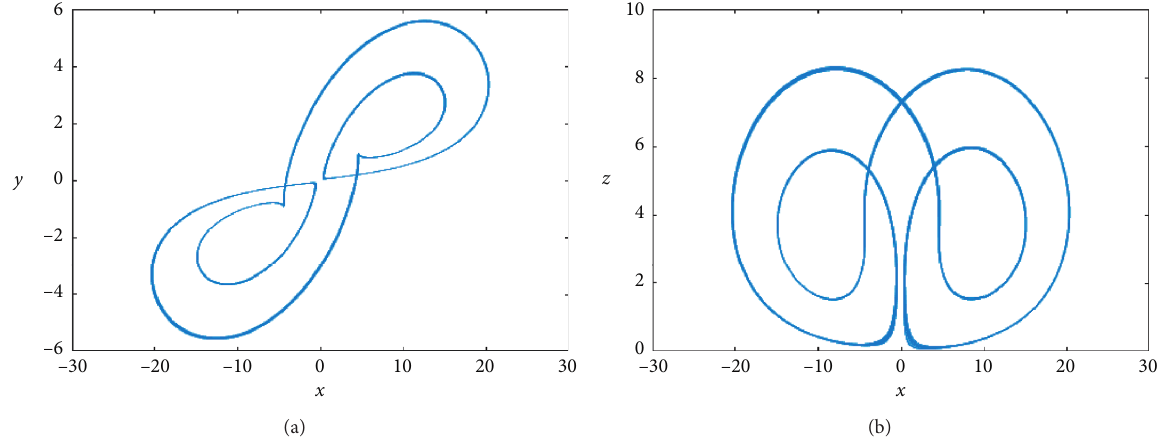
Figure 6: Phase portraits of limit cycle in (a) x − y and (b) x − z planes for initial conditions set as ( 1 , 0 , 0 , 30 )